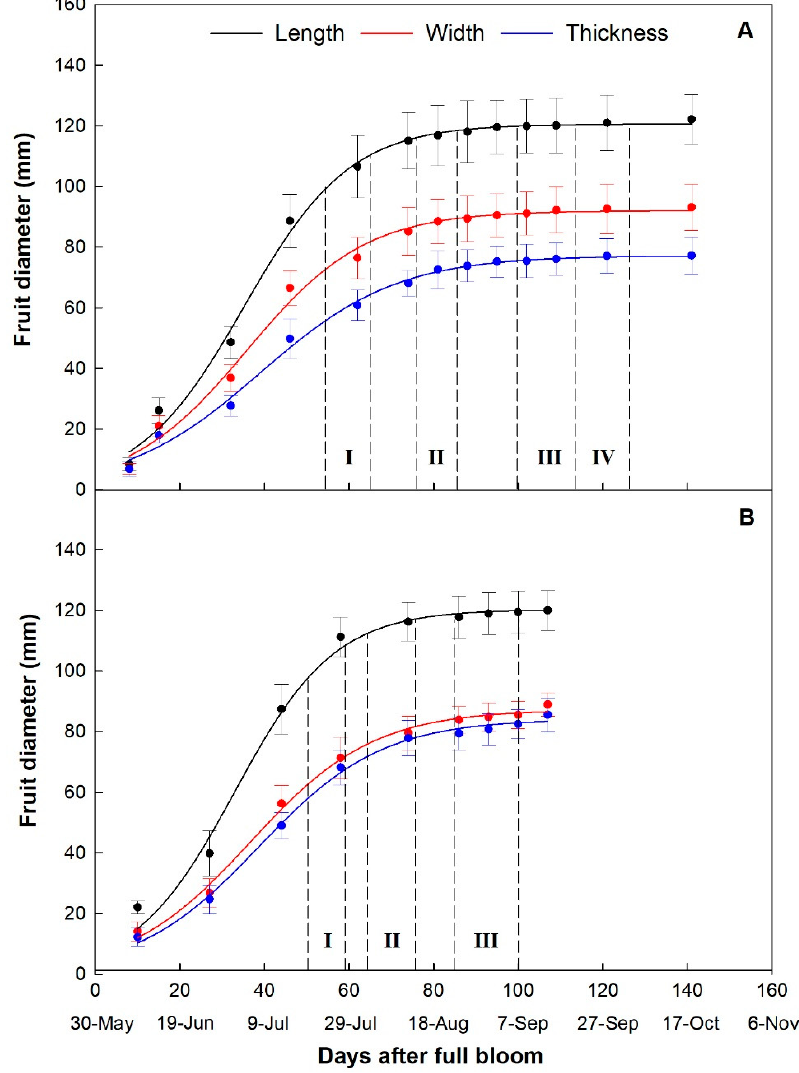
Figure 2. Fruit growth curve of ‘Keitt’ ( A ) in the four observation periods (I, II, III, IV), and ‘Tommy Atkins’ ( B ) in the three observation periods (I, II, III) monitored with a digital caliper. In ‘Keitt’, Length = 120.62/(1 + e ( − (DAFB − 35.11)/12.56) ); R 2 = 0.99. Width = 92.04/(1 + e ( − (DAFB − 35.84)/14.01) ); R 2 = 0.99. Thickness = 77.23/(1 + e ( − (DAFB − 39.01)/16.11) ); R 2 = 0.99. In ‘Tommy Atkins’, Length = 120.31/(1 + e ( − (DAFB − 32.95)/11.81) ); R 2 = 0.99. Width = 87.25/(1 + e ( − (DAFB − 36.66)/14.56) ); R 2 = 0.99. Thickness = 84.13/(1 + e ( − (DAFB − 38.66)/14.56) ); R 2 = 0.99.